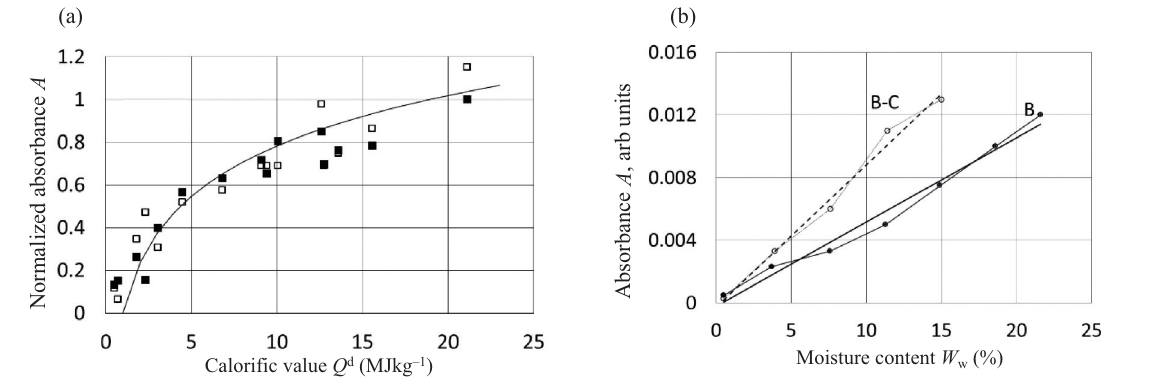
Fig. 4. (a) normalized absorbance as a function of caloricity; W = 14.5%; filled symbols – λ = 2305 nm peak; open symbols – w λ = 1725 nm peak; solid line – logarithmic fit of λ = 2305 nm data. (b) absorbance as a function of moisture content; open symbols – sample B/C ( Q d = 2.32 MJ/kg); filled symbols – sample B ( Q d = 21.12 MJ/kg) λ = 1925 nm peak.